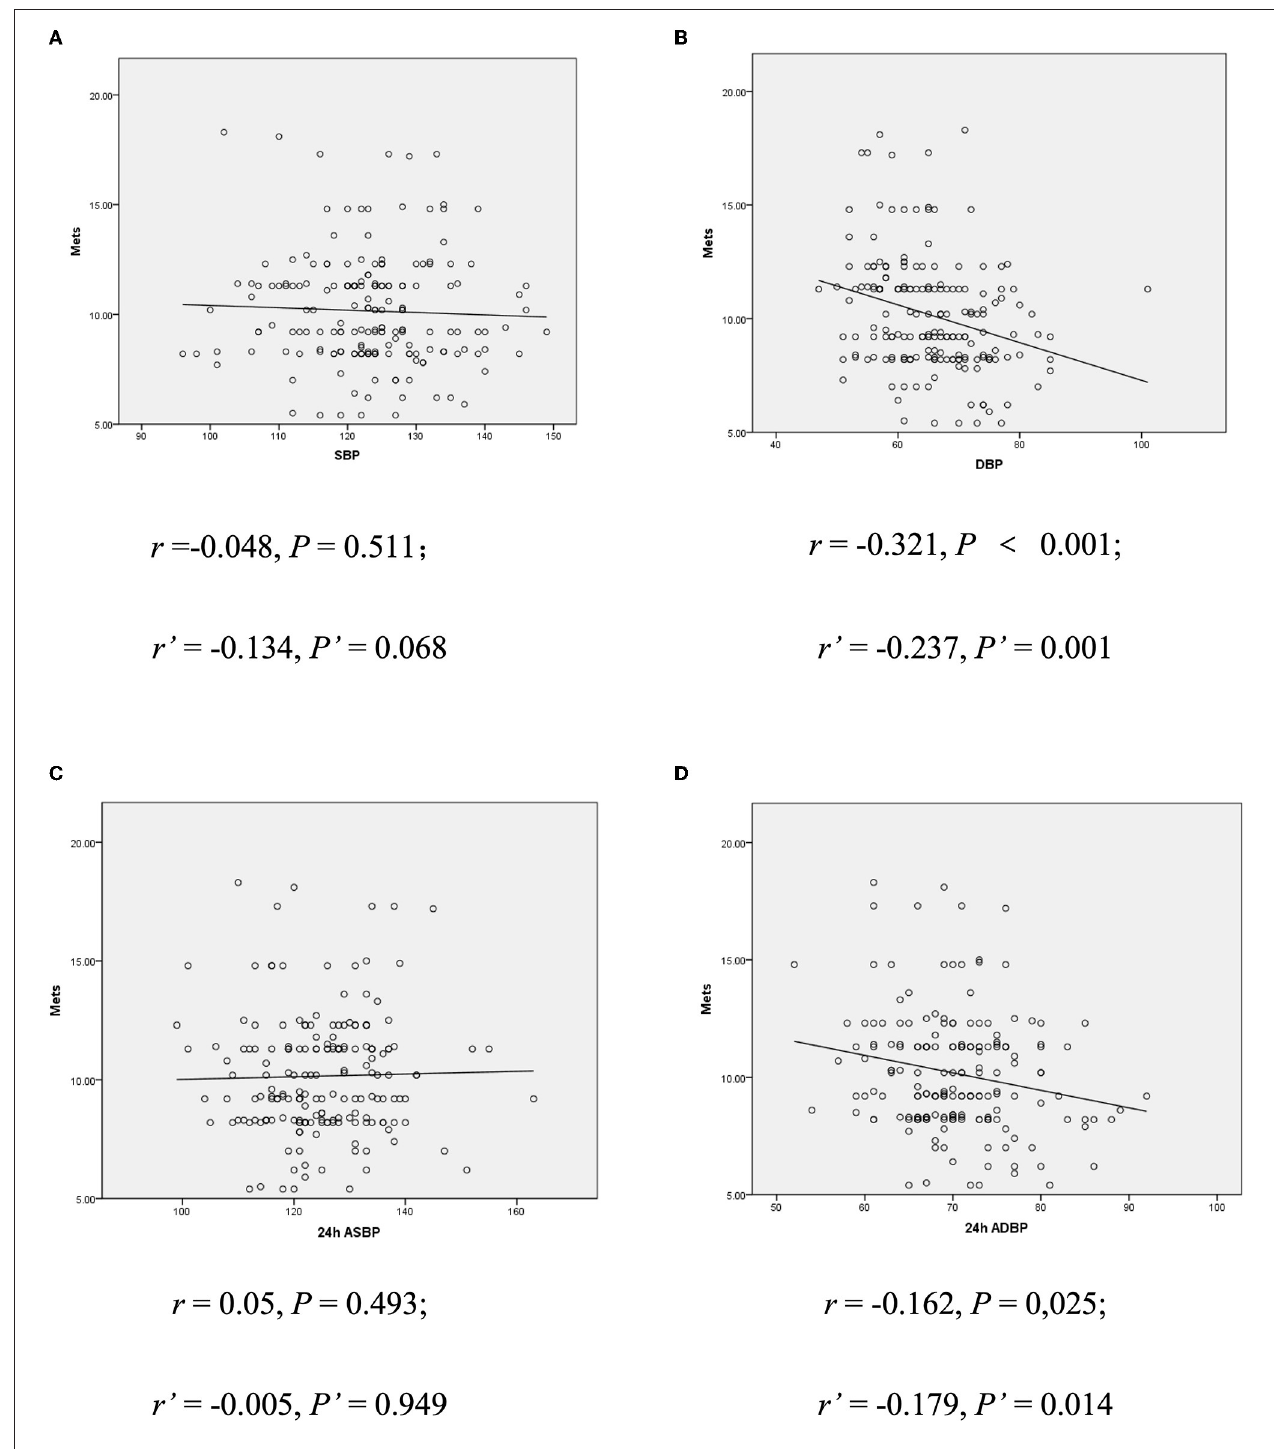
FIGURE 1 | (A) Correlation between resting SBP and METs. (B) Correlation between resting DBP and METs. (C) Correlation between 24 h ASBP and METs. (D) Correlation between 24 h ADBP and METs. r, Spearman rank correlation coefficient; r’, bias correlation coefficient corrected with gender and BMI; P’, P -value when corrected with age, gender, and BMI; DBP, diastolic blood pressure; METs, metabolic equivalents; ASBP, average systolic blood pressure.